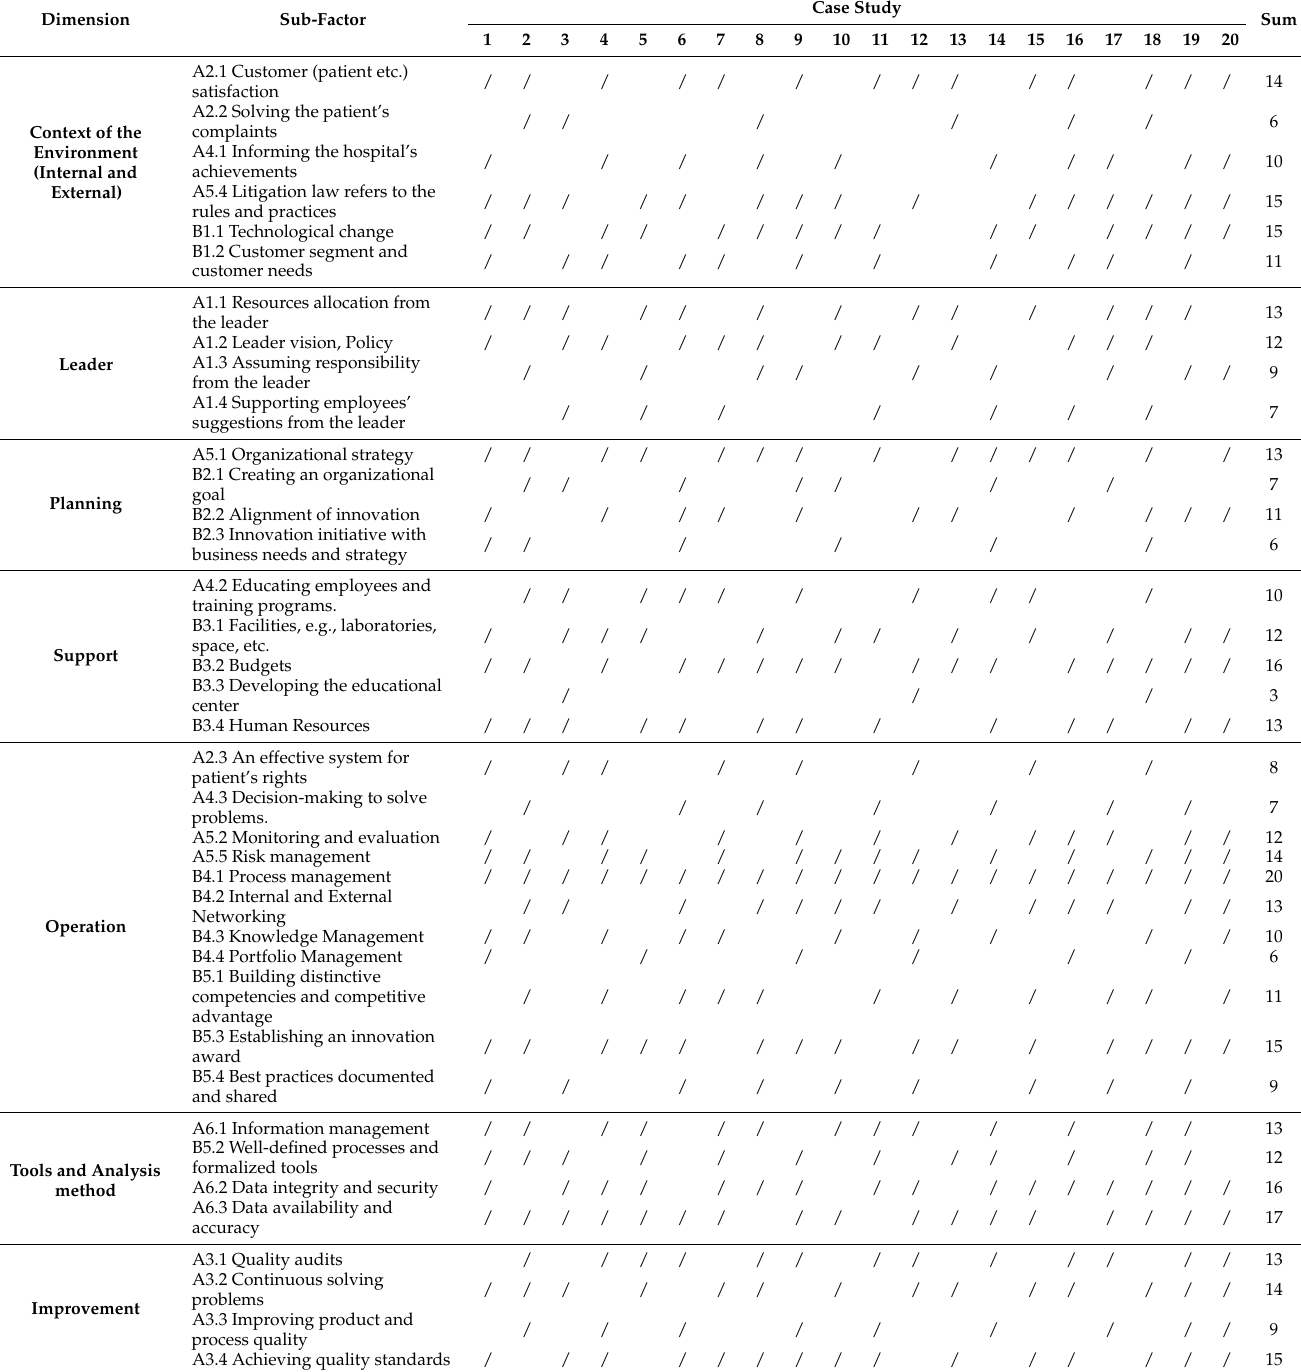
Table 3. TQIM-H factors analysis from 20 innovation case